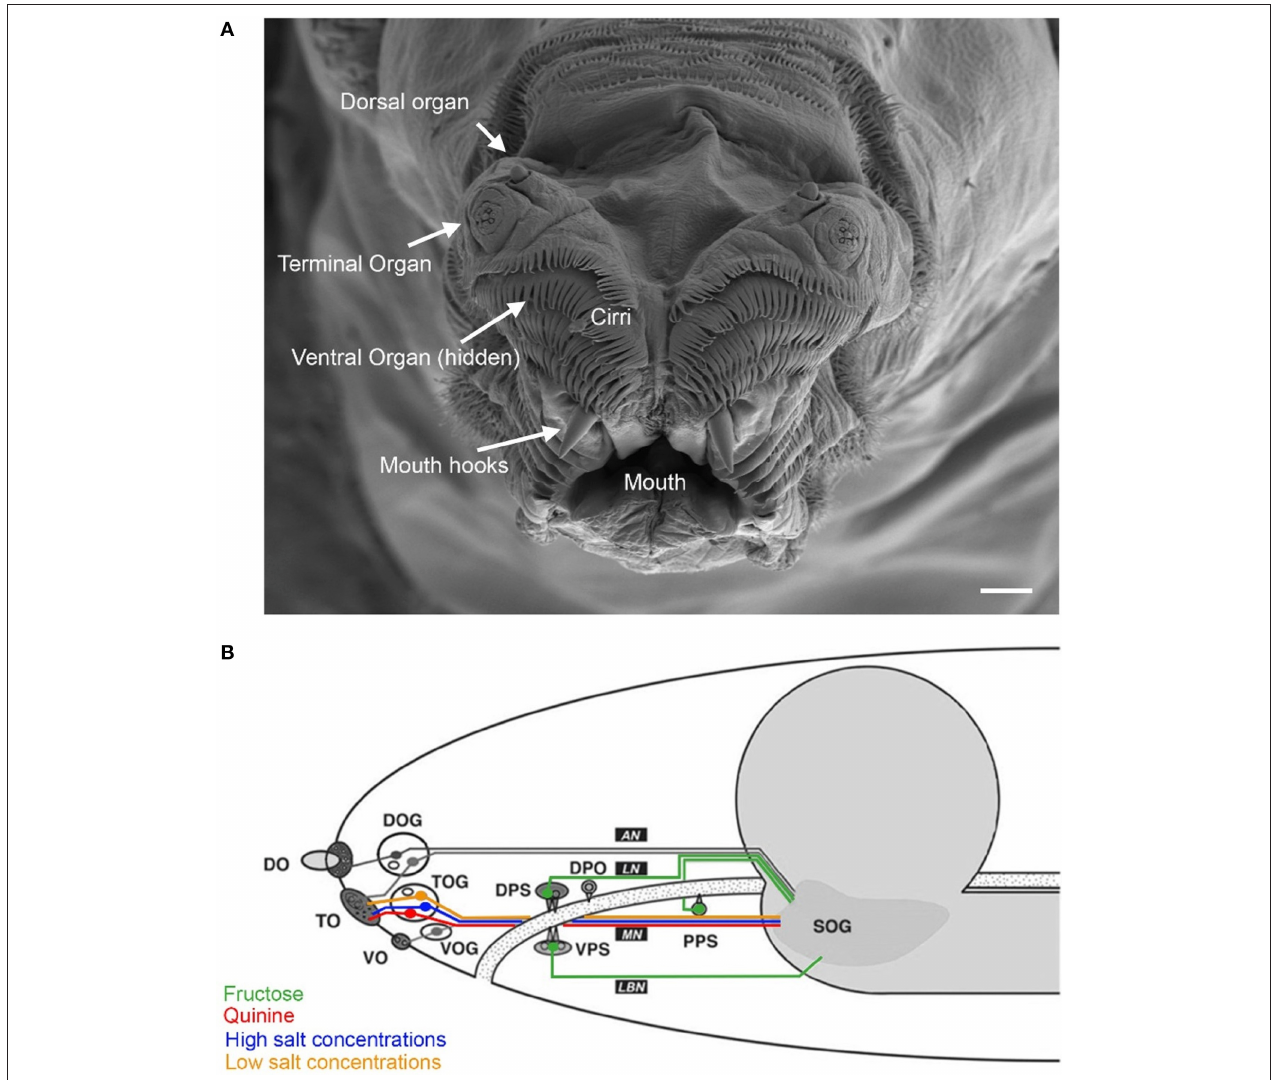
FIGURE 1 | Anatomy of the larval taste system. (A) Fine structure of the larval cephalic organs: frontal view of the larval cephalon with the external sensory organs on each cephalic lobe: the dorsal organ (DO), the terminal organ (TO), the ventral organ (VO), which is hidden behind a row of cirri (hairlike, cuticle structures around the mouth opening). All organs are located as paired structures dorsally to the mouth and mouth hooks. (B) Schematic overview on the cephalic and pharyngeal chemosensory system. Shown are the major gustatory and olfactory organs, respective ganglions and central projections. Four main nerves connect the chemosensory organs with the central nervous system: antennal nerve (AN), labral nerve (LN), maxillary nerve (MN) and labial nerve (LBN). The brain is shown in gray. Olfactory processes of the DO innervate the larval antennal lobe via the AN. Putative gustatory DO projections are assumed to enter the subesophageal ganglion (SOG). Three cells from the DO ganglion send their dendrites into the TO. The TO and the VO project along the MN which enters the SOG. Four pharyngeal organs locate along the pharynx (PH). Projections from the VPS innervate the SOG over the LBN. The DPS, the DPO and the PPS send projections along the LN to the SOG. (Figure modified from Python and Stocker, 2002; Gerber and Stocker, 2007). Scale bar: 20 µ m.